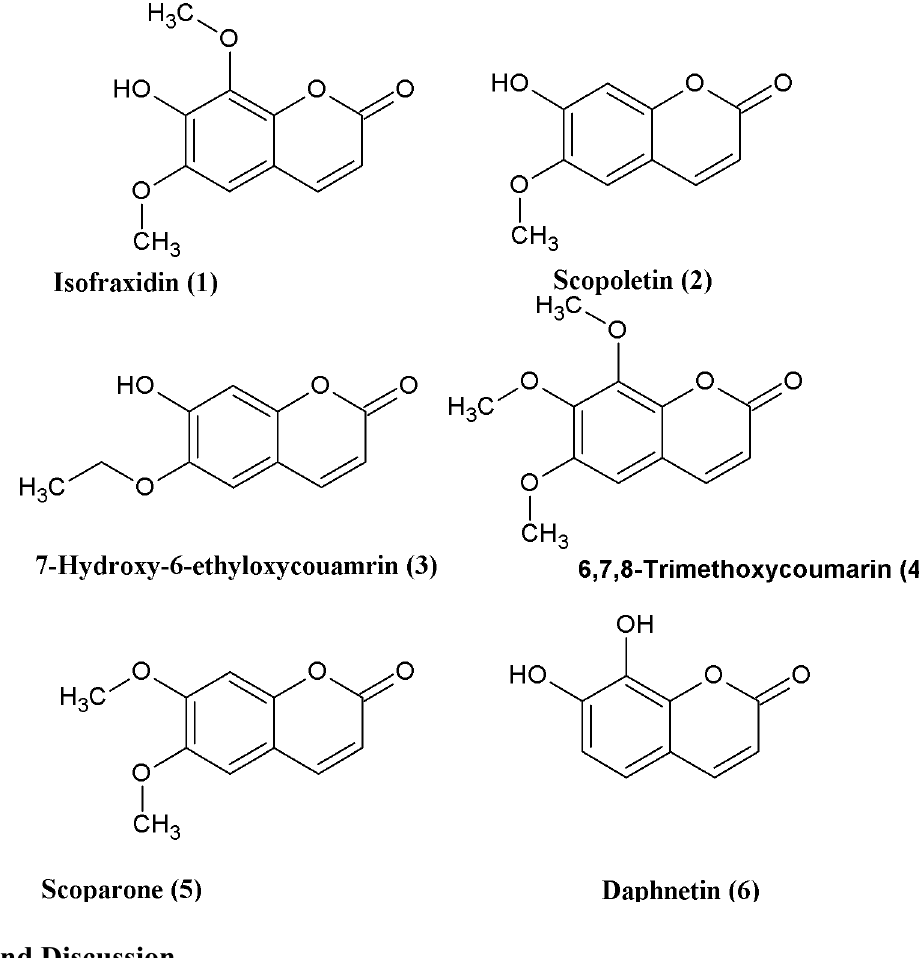
Figure 1. The structure of the synthesized